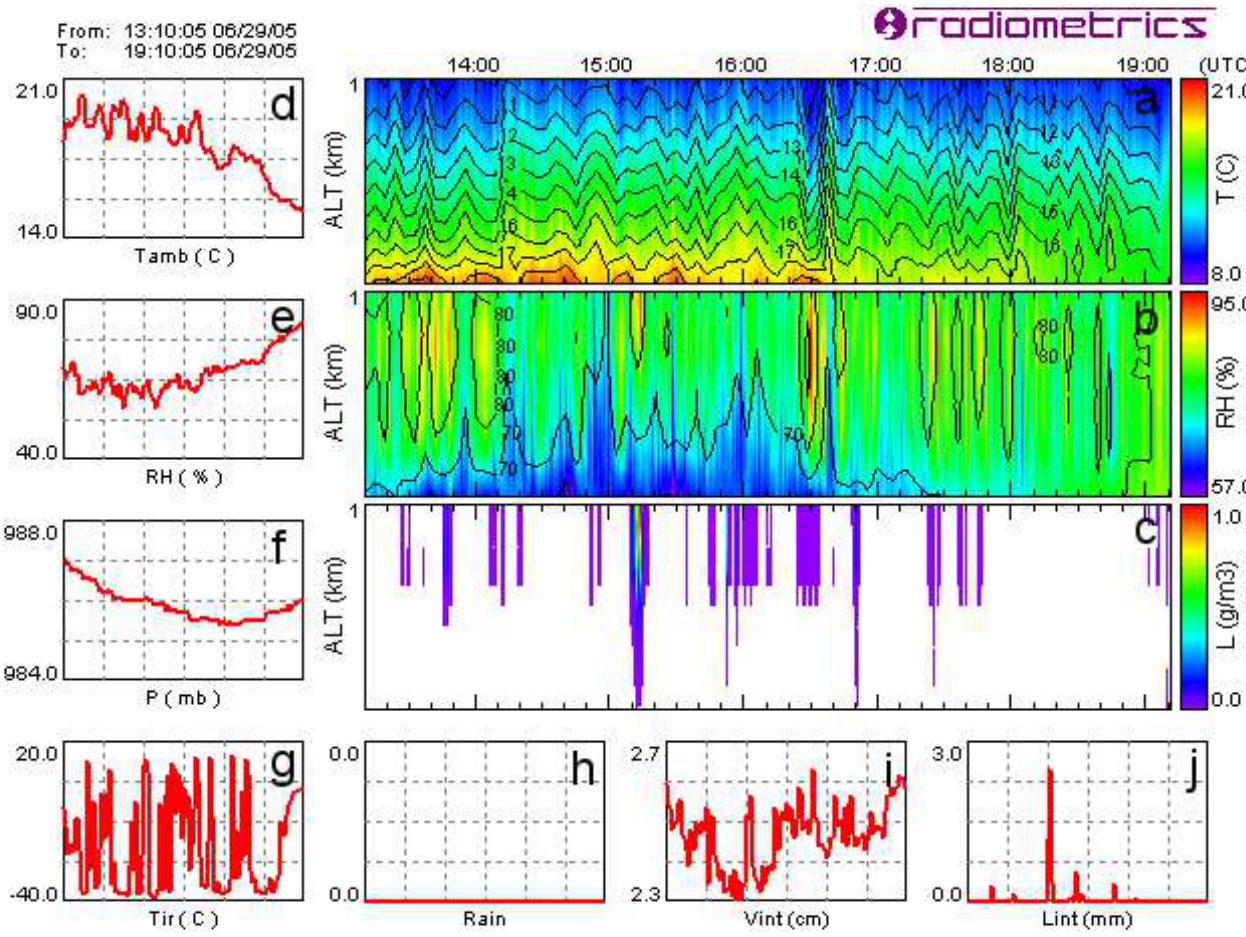
Fig. 11. Microwave radiometer retrieval showing (a) temperature, (b) relative humidity and (c) liquid water time-height cross sections for 0–1km height, 29 June 2005, 13:10–19:10UTC. Time series of scalars are also shown in red for (d) surface temperature, (e) surface relative humidity, (f) pressure, (g) infrared brightness temperature, (h) rain sensor, (i) integrated water vapour and (j) integrated